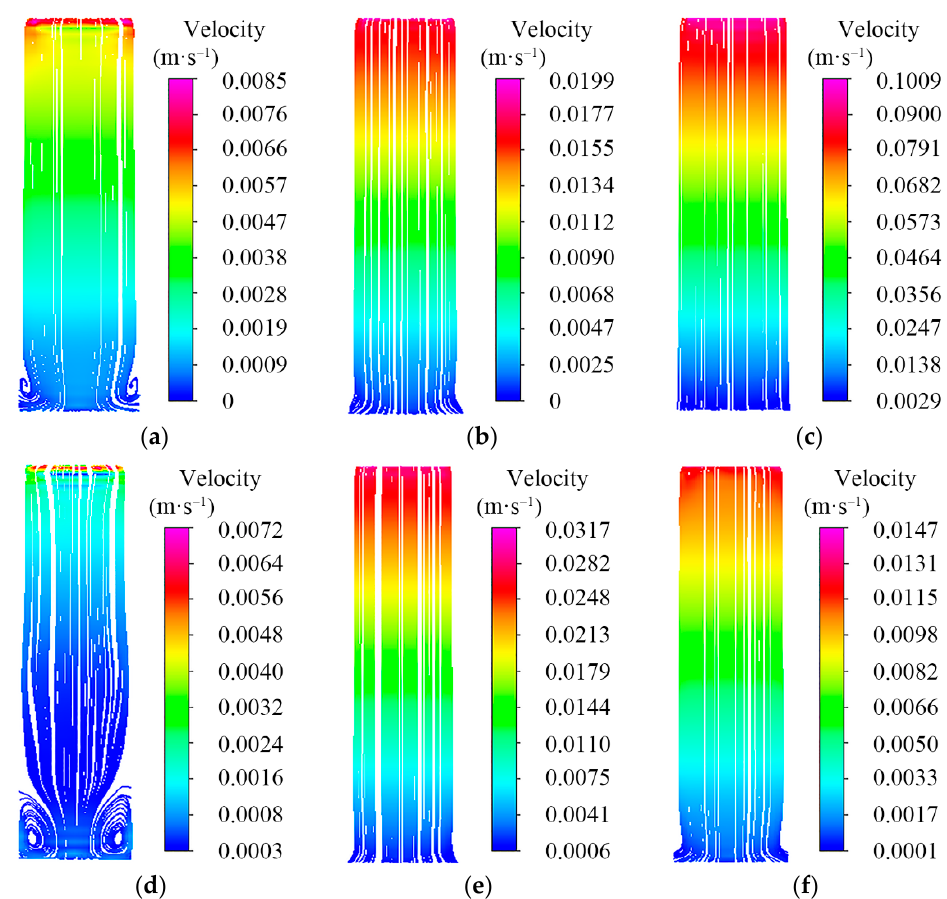
Figure 16. ( a ) Streamline distribution in the fluid domain of the two-level cylinder under condition ( a ). ( b ) Streamline distribution in the fluid domain of the two-level cylinder under impact 0.01 s. ( c ) Streamline distribution in the fluid domain of the two-level cylinder under impact 0.02 s. ( d ) Streamline distribution in the fluid domain of the two-level cylinder under impact 0.03 s. ( e ) Streamline distribution in the fluid domain of the two-level cylinder under impact 0.04 s. ( f ) Streamline distribution in the fluid domain of the two-level cylinder under impact 0.05 s.